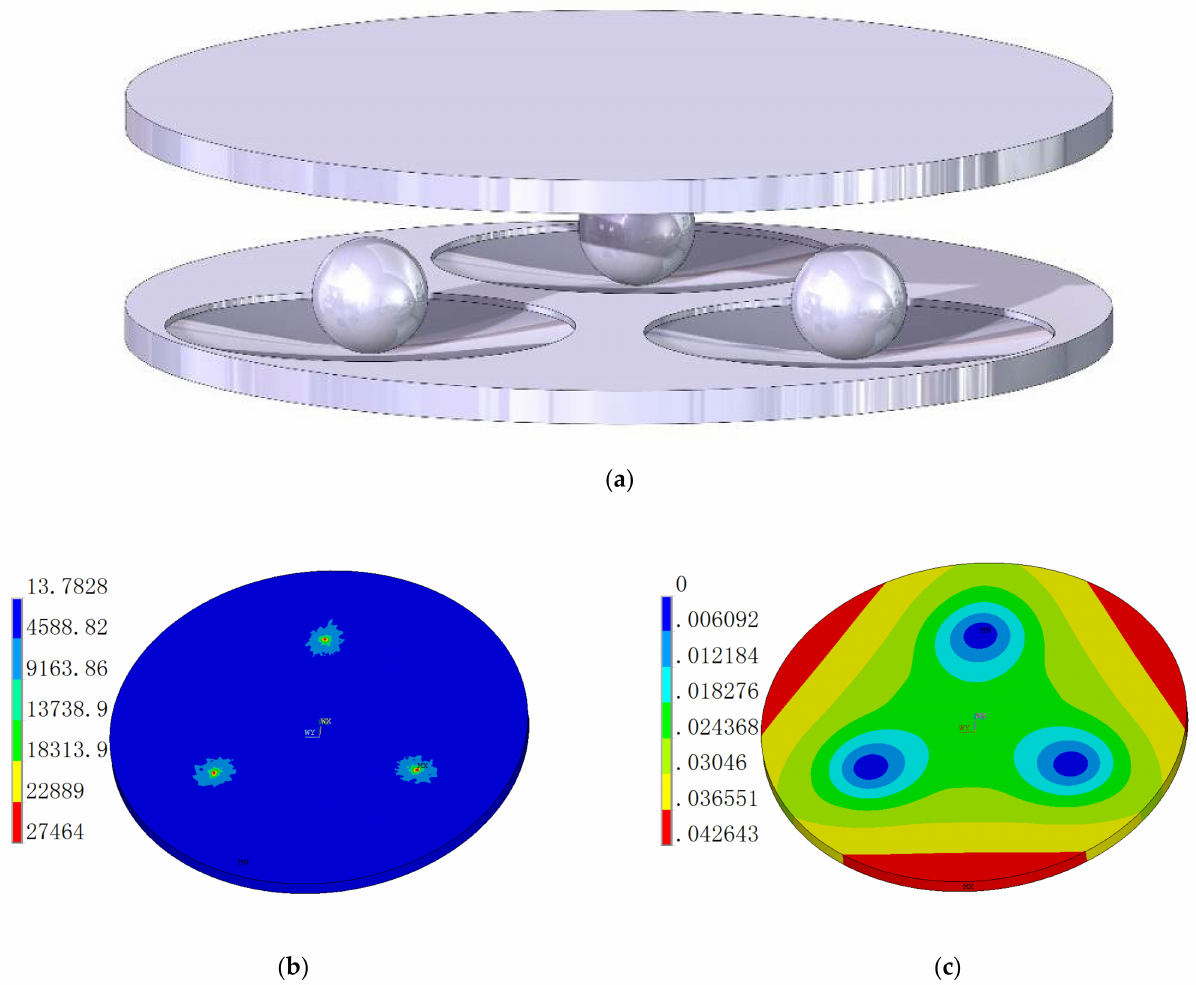
Figure 8. ( a ) Schematic diagram of the device; ( b ) Stress contours of the upper plate (kPa), and ( c ) deformation contours of the upper plate